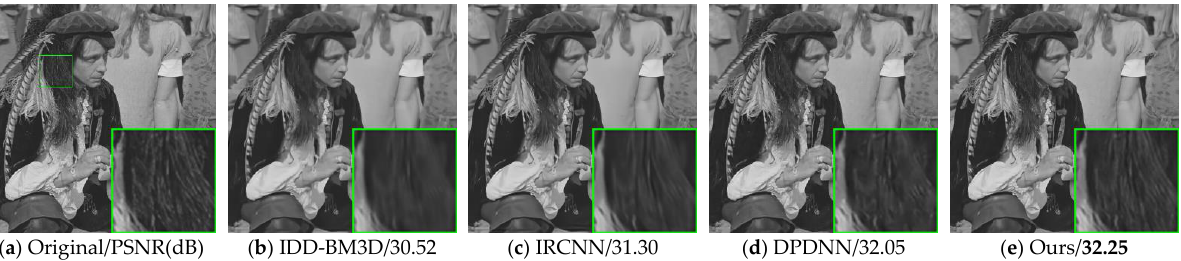
Figure 7. Image deblurring results on Man in Figure 3 with 19 × 19 motion blur kernel and σ n = 2.55. ( a ) The original image. ( b ) The result of IDD-BM3D. ( c ) The result of IRCNN. ( d ) The result of DPDNN. ( e ) Our result.